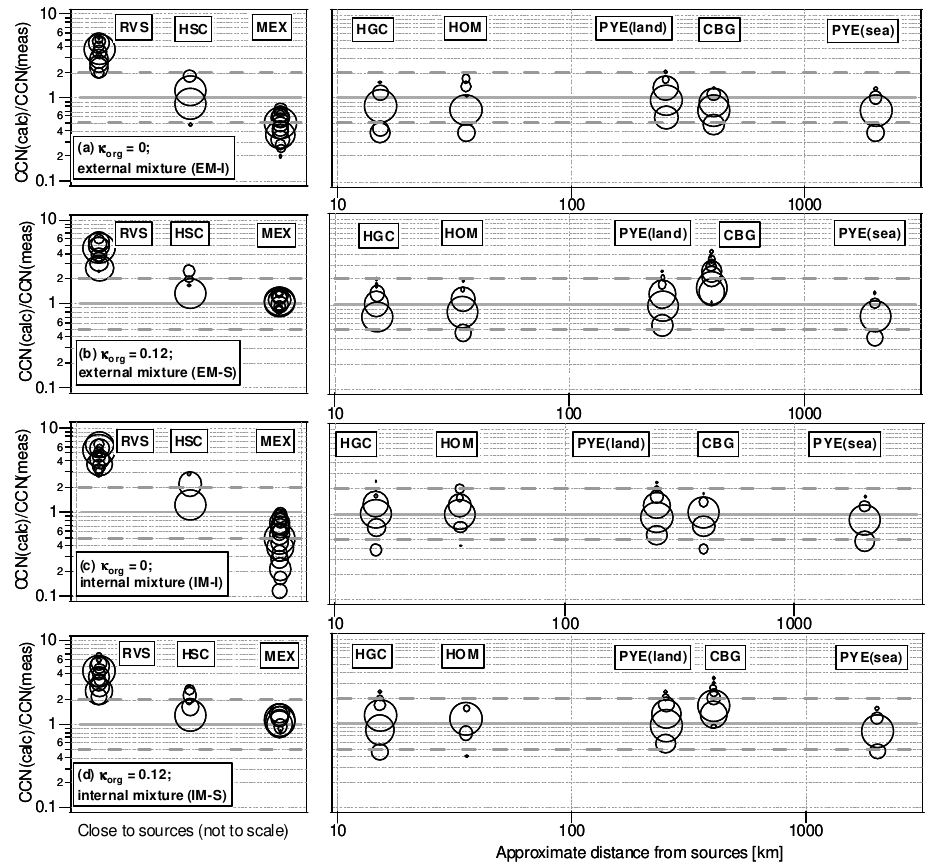
Fig. 2. Ratio of calculated to measured CCN number concentration for seven different data sets. The symbol size corresponds to the frequency of the respective ratio in the CCN closure. Horizontal lines denote the 1:1 line (solid line) and ratios of 0.5 and 2 (dashed lines),